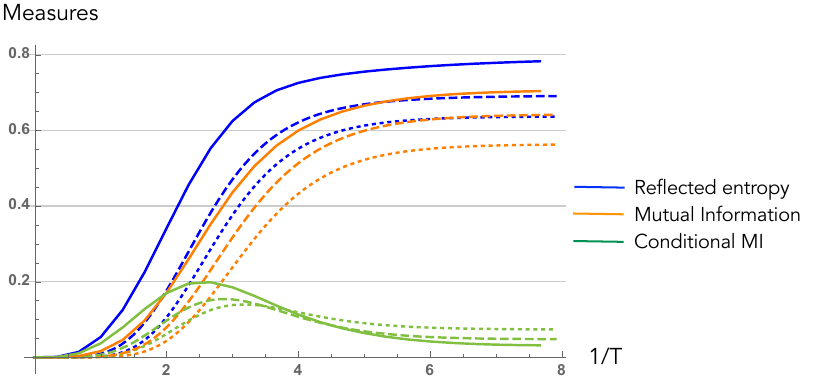
Figure 12 . For the XY model, with { g = 0 , N = 8 , γ = 1 / 2 } , the temperature dependence of the reflected entropy (blue) is shown, in comparison with the mutual information (orange) and the conditional mutual information (green). We consider various lengths ‘ = 2 , 4 , 6 of the subsystem C , shown by solid, dashes and dots